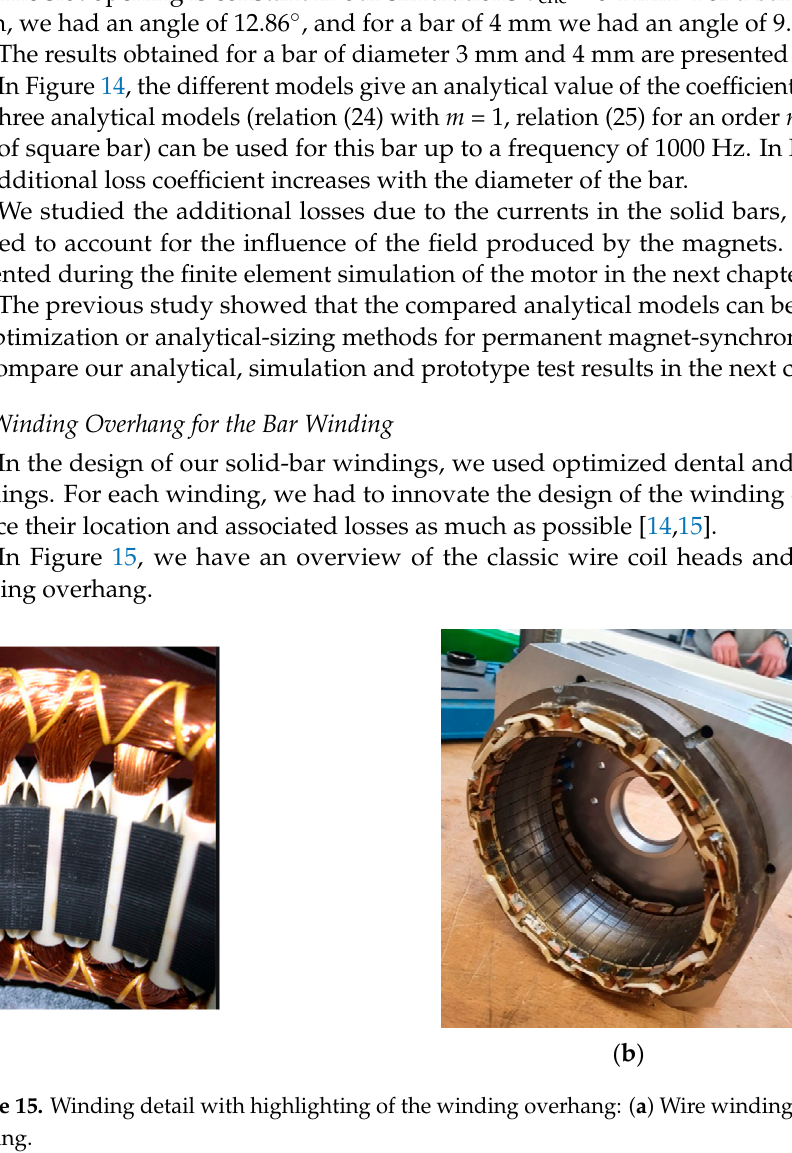
Figure 14. Losses coefficient as a function of frequency ( a ) R = 1.5 mm, ( b ) R = 2 mm.